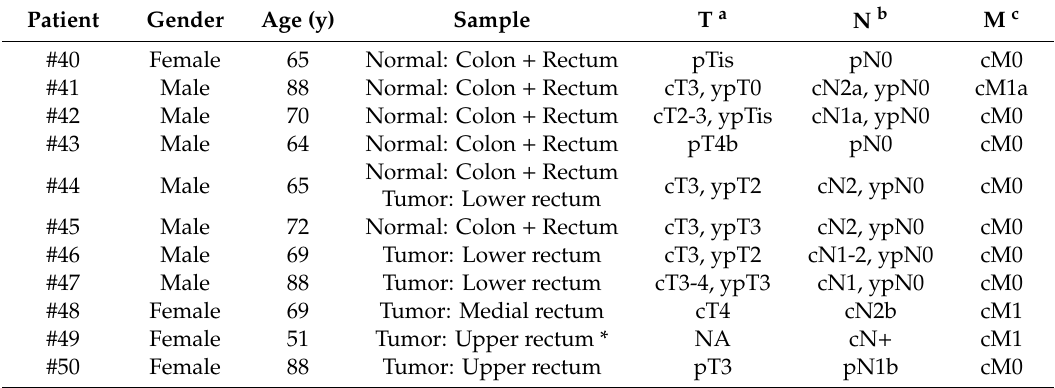
Table 1. Clinicopathological characteristics of rectal tumor patients from whom biopsies were obtained to generate organoid